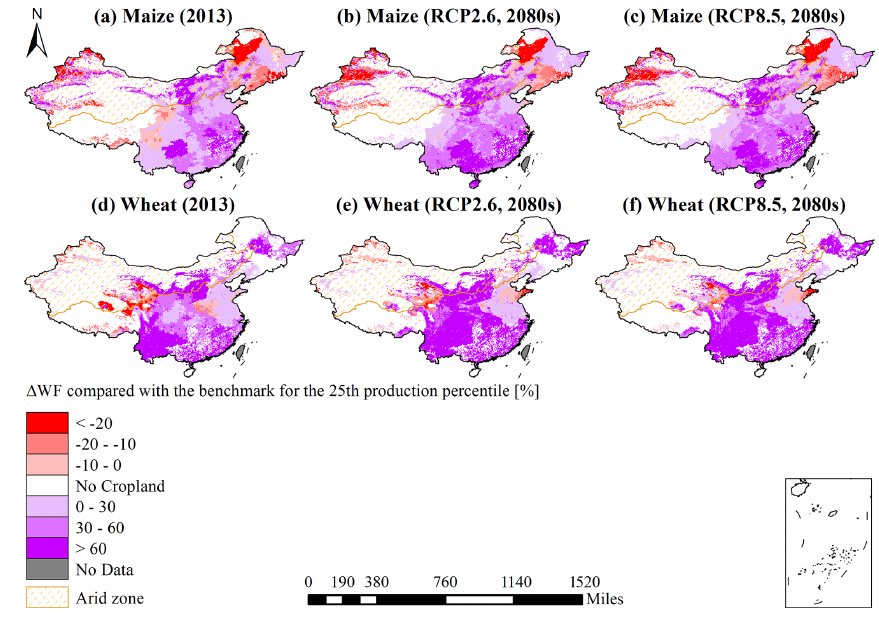
Figure 8. Relative changes (cid:49) (%) in the WFs of maize and wheat compared with the benchmark for the 25th production percentile in 2013 and in the 2080s under RCP2.6 and RCP8.5 in different climate zones of China. Please note that 1 mile in the scale bar represents approximately